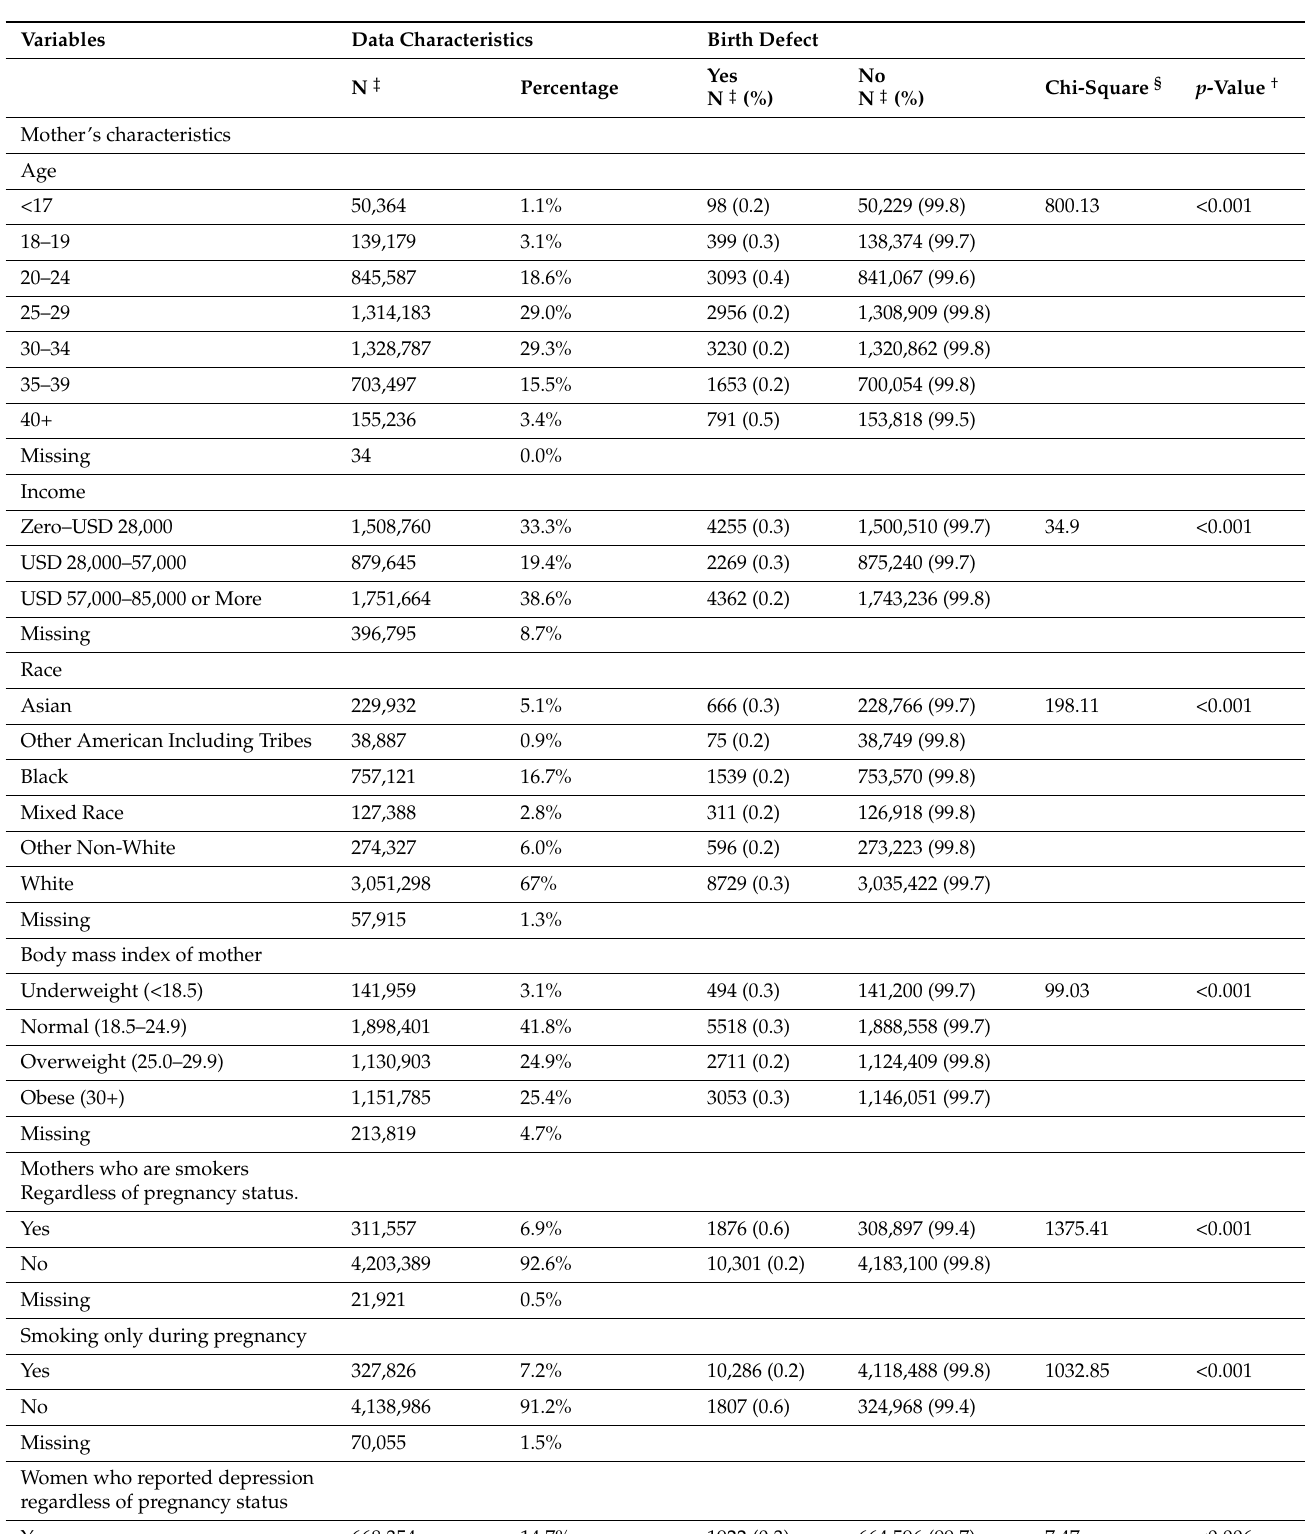
Table 1. Sociodemographic information of pregnant women; the United States,